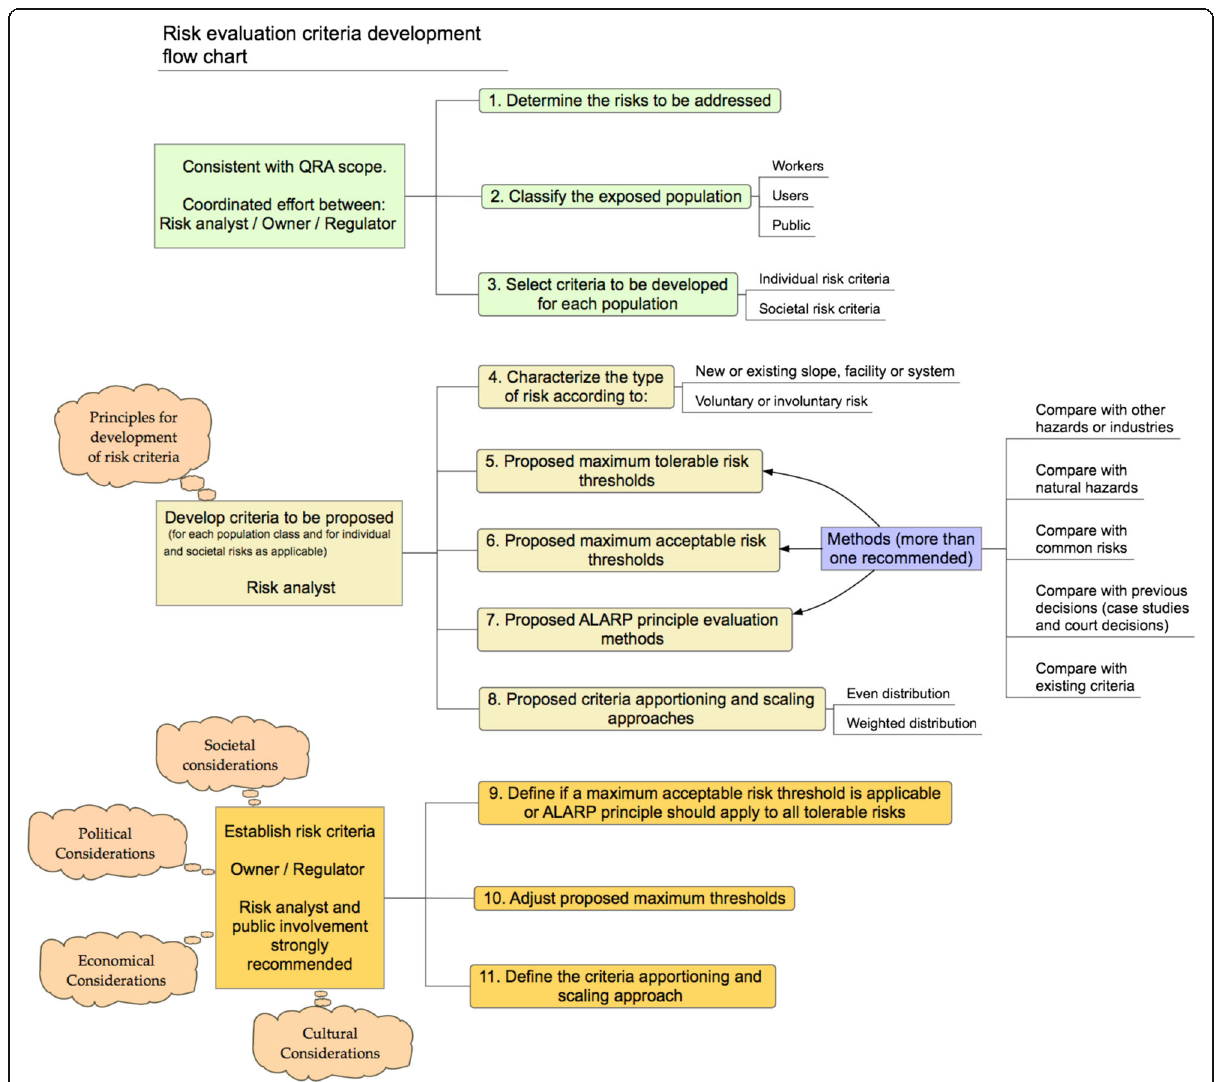
Fig. 2 Proposed framework for the development of risk to life evaluation